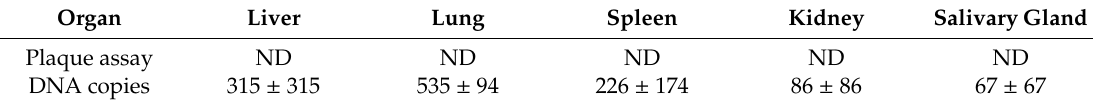
Table 3. Assay of MCMV-infected mouse organs for latency establishment. Organ Liver Lung Spleen